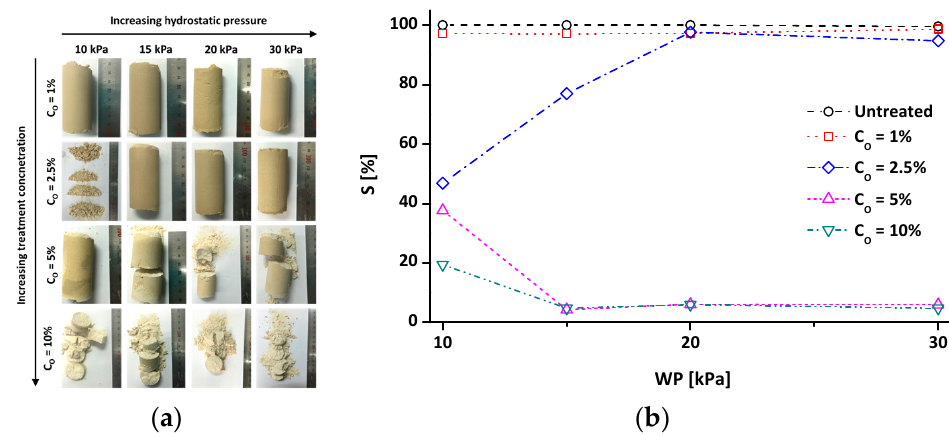
Figure 7. After a water infiltration time (WIT) experiment, ( a ) disassembled specimens;